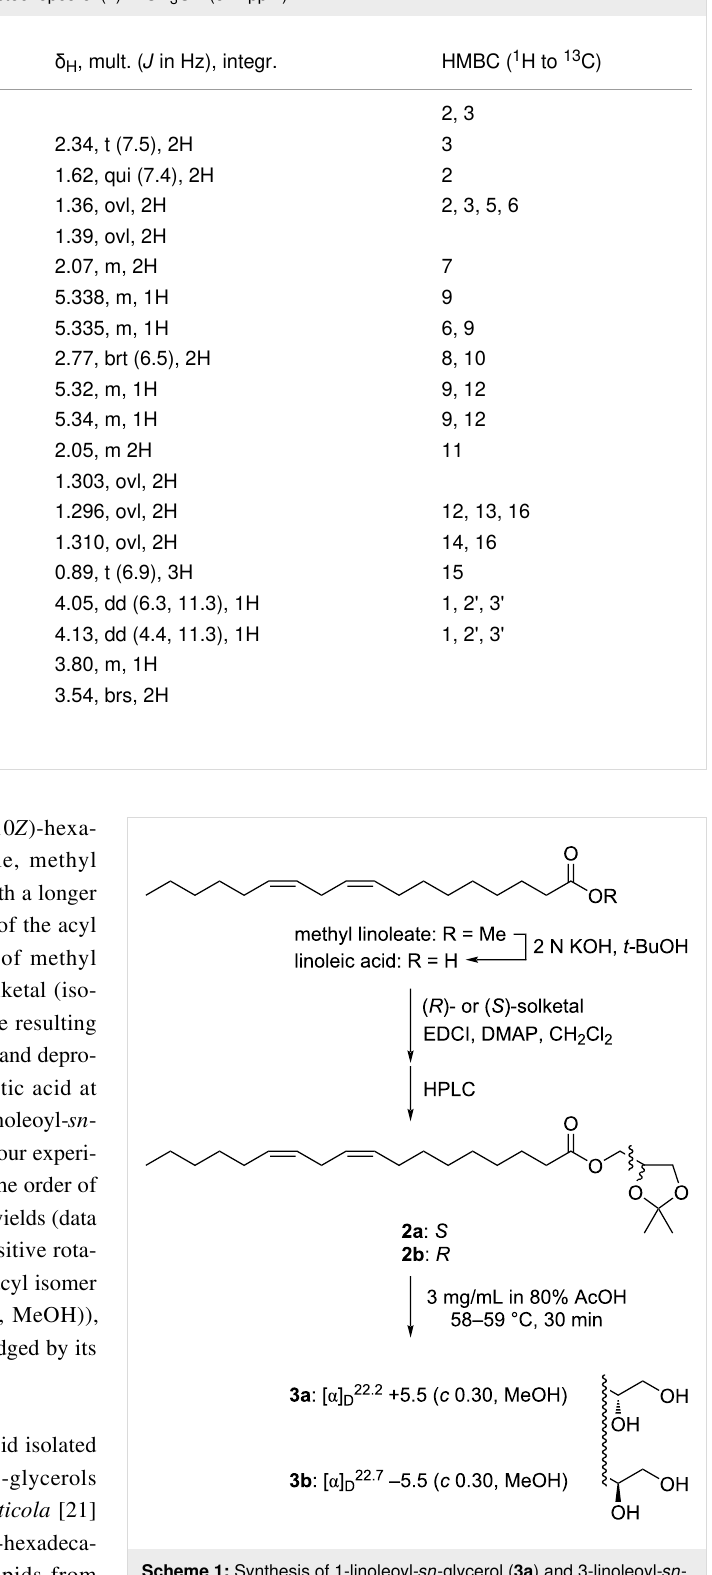
Table 1: 1 H (500 MHz) and 13 C (125 MHz) NMR data for nostochopcerol ( 1 ) in CD 3 OH ( δ in ppm).